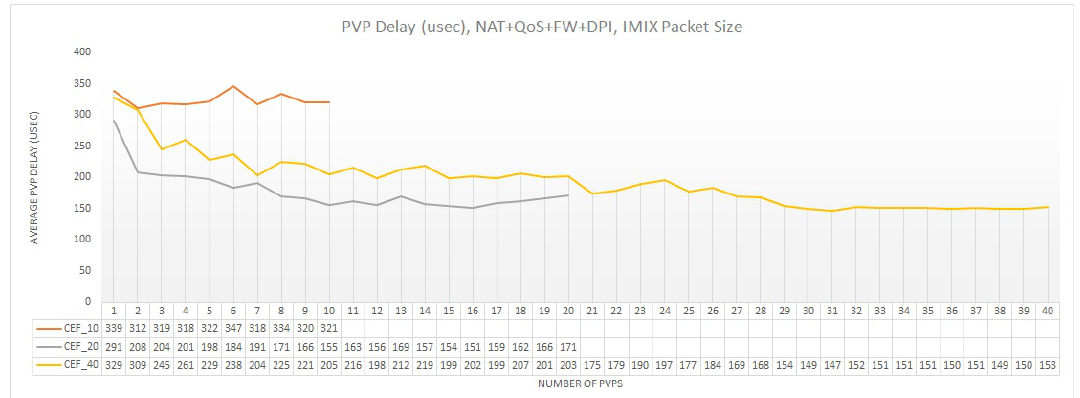
Figure 13. Multi-Feature multi-PVP average delay with NAT, QoS, FW, and